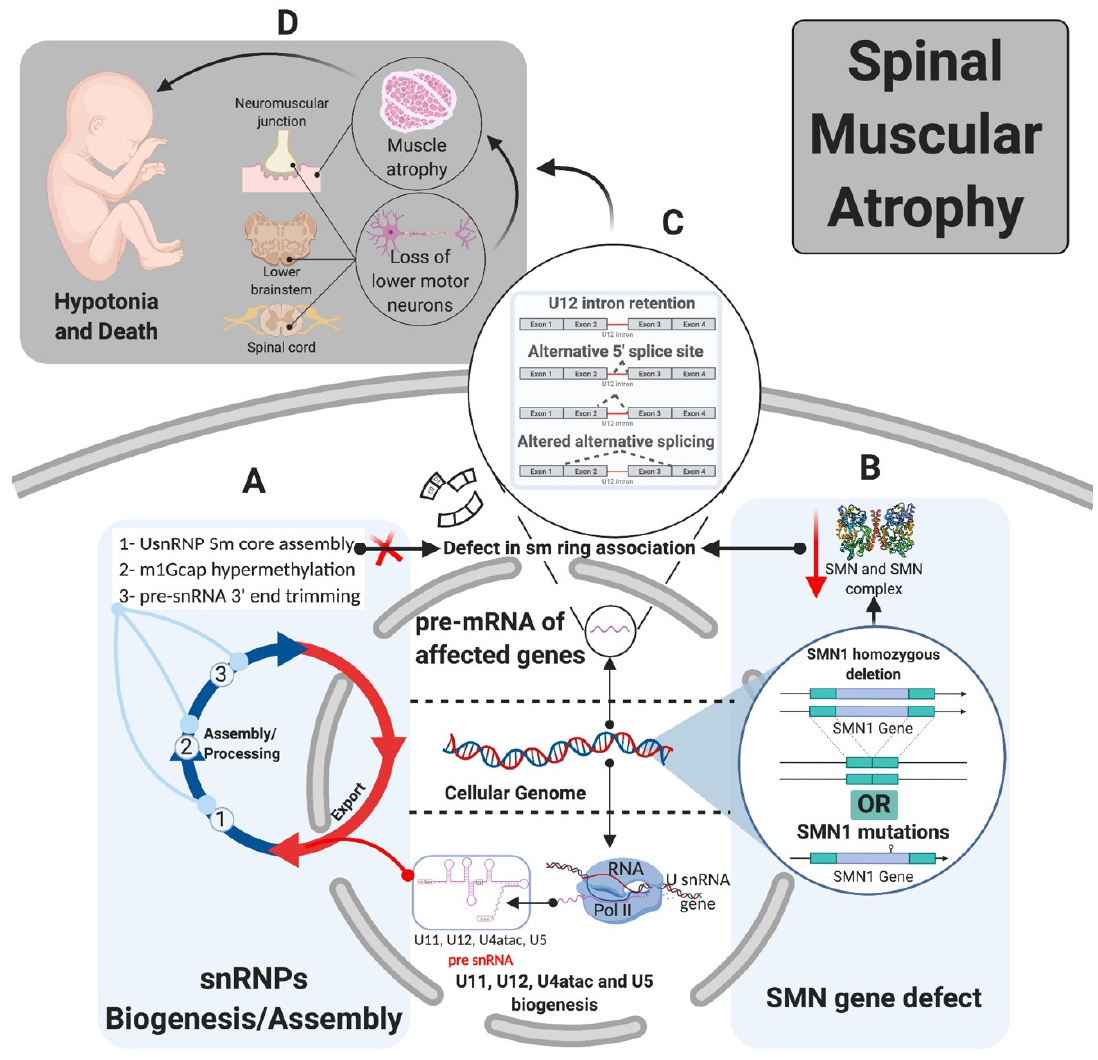
Figure 5. Tissue specificity of mi-INTs-related diseases (SMA). ( A ). snRNP biogenesis and assembly requires SMN along with other proteins (SMN complex) for Sm core assembly, m1Gcap hypermethylation, and pre-snRNA 3’end trimming. ( B ). Loss or mutation in SMN1 with retention of SMN2 product allows the production of SMN at lower levels leading to lower SMN complex level and lower ability to interact with Sm proteins, preventing the formation of the Sm ring and mature snRNPs (major and minor) which preferentially affects minor snRNPs [28–30] leading to splicing defects. ( C ). Splicing defect in U2 and U12-type intron splicing with bias toward U12-type intron retention [29,31] leads to aberrant mRNA transcripts that may be degraded or produce aberrant proteins. ( D ). Phenotype of SMA depends on the severity of the illness, which is caused by motor neuron degeneration in the brain stem, anterior horn of the spinal cord, and muscle atrophy. This leads to hypotonia and eventual death [32,33].